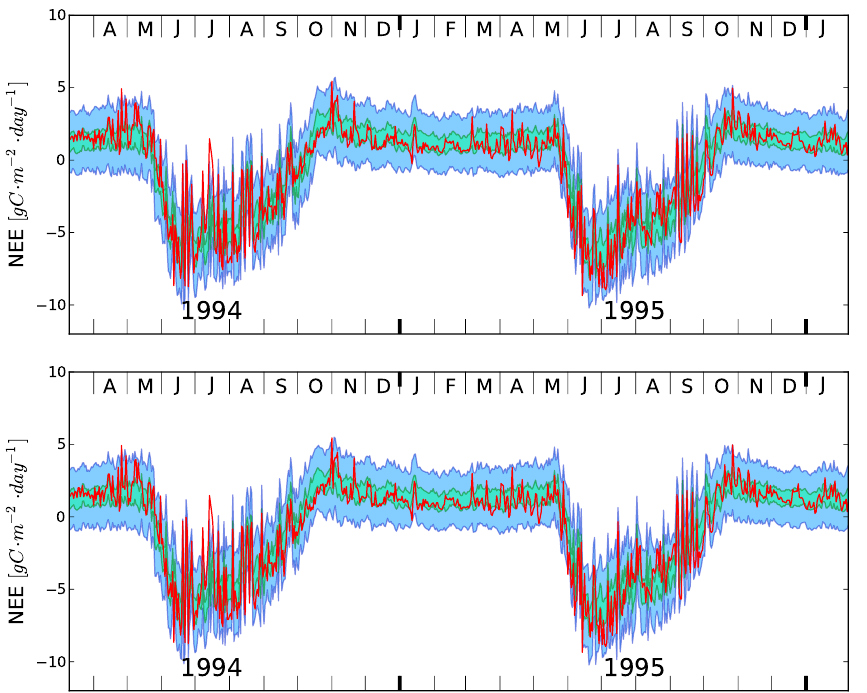
Figure 17. Marginal posterior predictive densities using the calibration results for D ST (top frame) and D TR (bottom frame) presented in Sect. 4. The blue regions correspond to the daily 5–95% quantile range and the green regions to 25–75% quantile range. The red line shows the daily NEE